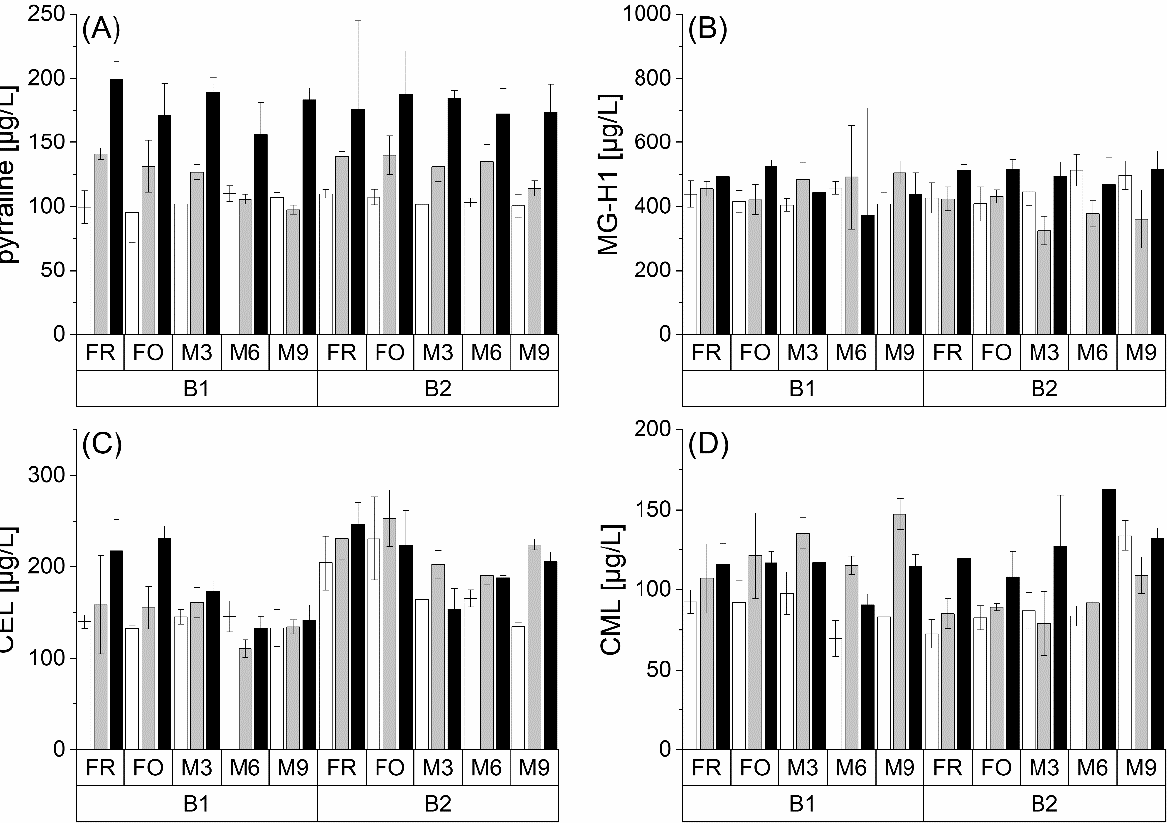
Figure 5. Concentrations of free AGEs (( A ) pyrraline, ( B ) MG-H1, ( C ) CEL, and ( D ) CML) at fresh (FR), forcibly aged (FO), and naturally aged (M3, M6, and M9) beer at different malt modification levels (P1: white bar; P2: grey bar; P3: black bar) in two barley varieties (B1 and B2); n = 3 .